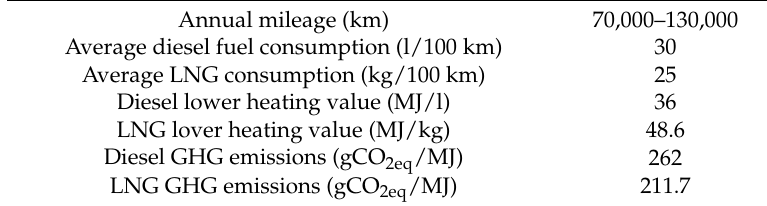
Table 3. Parameters for calculation of annual greenhouse gasses (GHG) emissions.